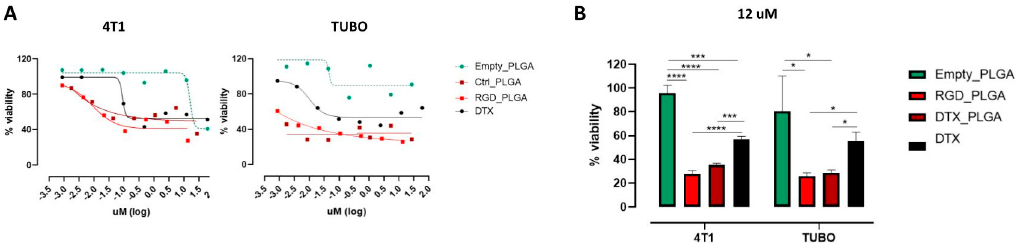
Figure 4. Effect of DTX_PLGA on BC cell viability. ( A ) MTT assays on TUBO and 4T1 cell lines per- formed with PLGA-NPs with and without Docetaxel, and Docetaxel alone at various concentrations. ( B ) Cell viability of the same cells treated with 12 µ M Docetaxel (free or encapsulated in PLGA-NPs), or with empty PLGA. *, p < 0.05; ***, p < 0.001; ****, p < 0.0001, Student’s t